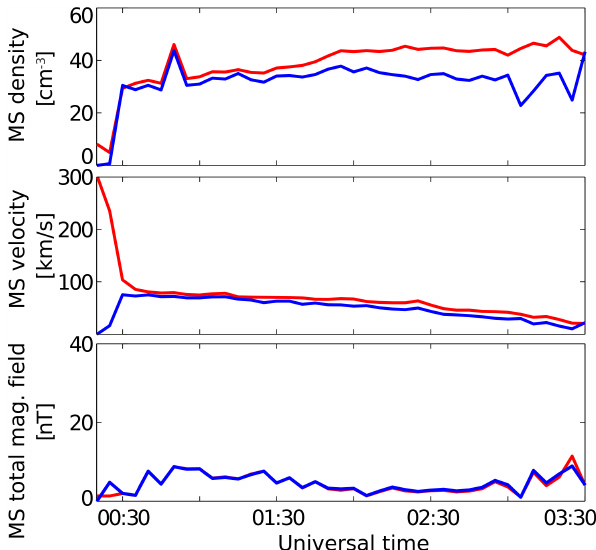
Figure 9. The magnetosheath density (top panel), the ion velocity (middle panel), and the magnetic field (bottom panel), which are observed by THEMIS on 24 August 2008, are presented in red. The best match for the data to the magnetosheath model for any choice of the solar wind boundary parameters was found for the magne- tosheath model predictions, which are shown in